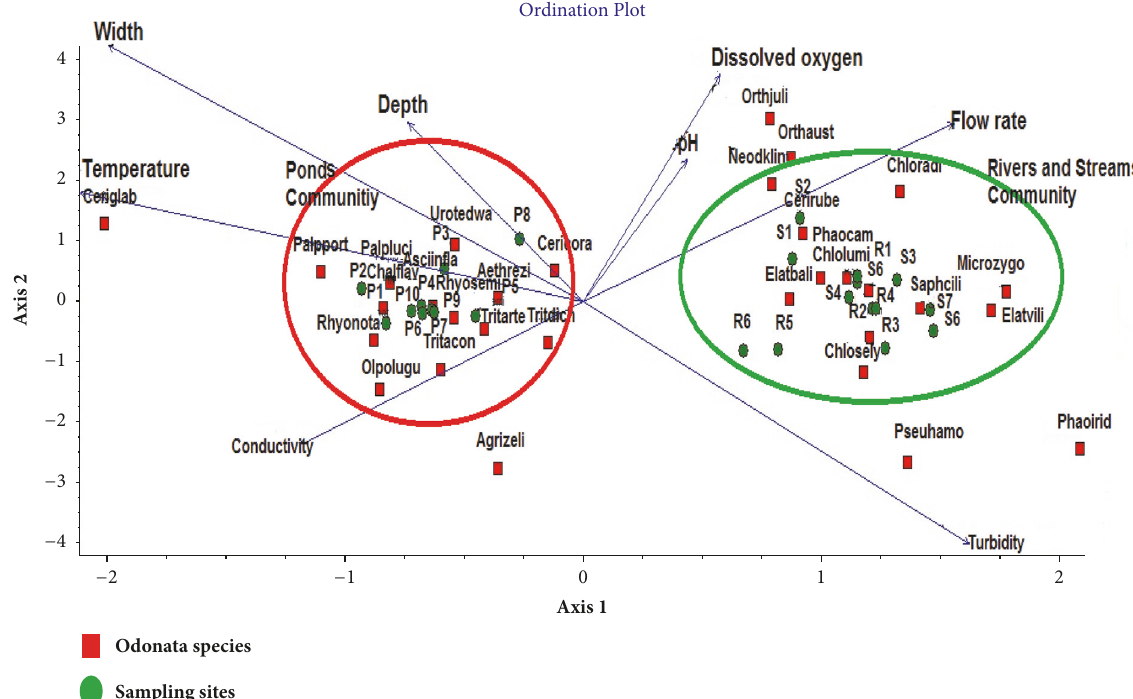
Figure 10: Canonical correspondence analysis (CCA) ordination diagram, showing the relationship between environmental variables and Odonata species across the three water types in the Ankasa Conservation Area in Ghana. Species names are abbreviated with the first four letters of the genus and the first four letters of the species following Seidu et al., [17]. The blue arrows represent each of the environmental variables plotted pointing in the direction of maximum change of explanatory variables across the water types. Red and green ovals represent specialists’ species in lentic (ponds) and lotic (rivers and streams),